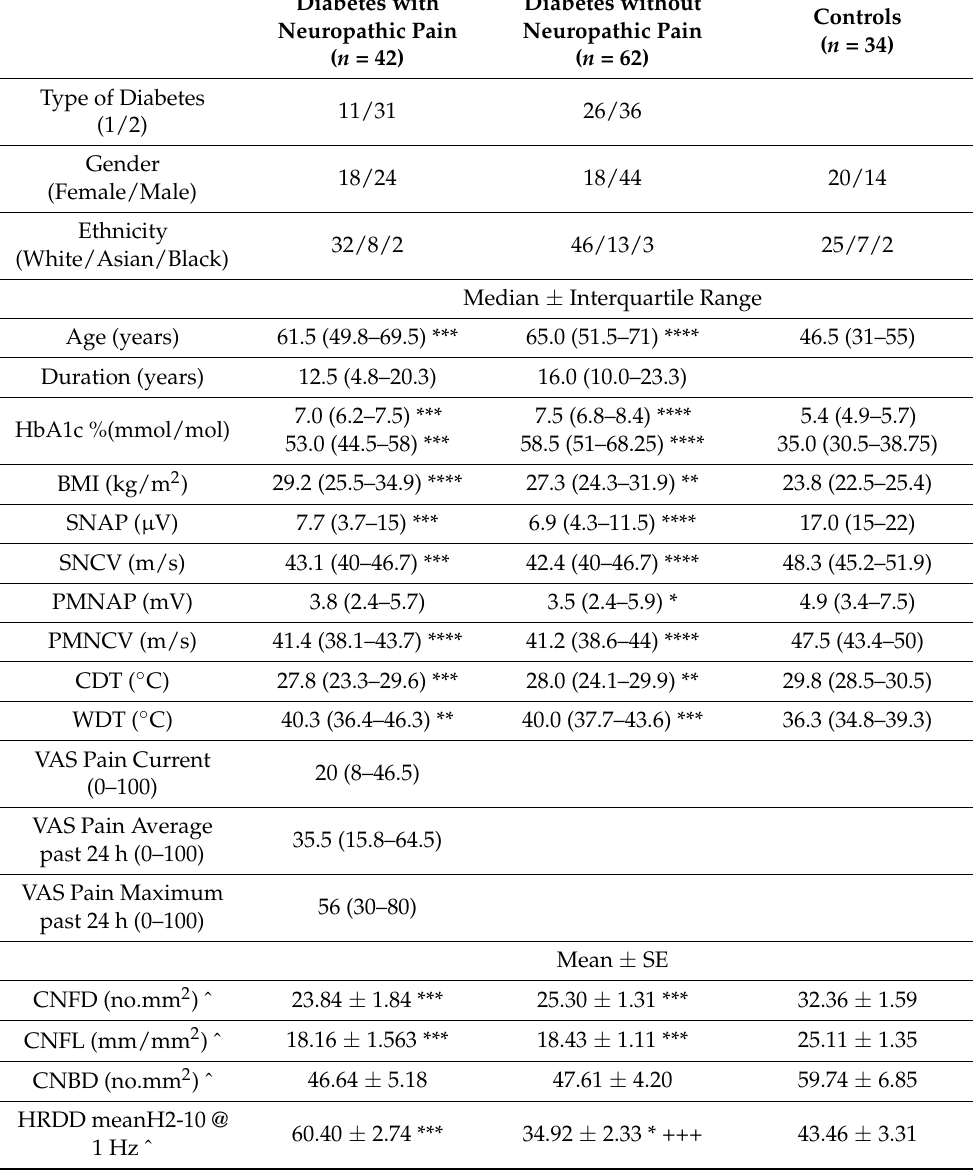
Table 1. Demographic and neuropathy parameters for patients with diabetes, with and without neuropathic pain, and control